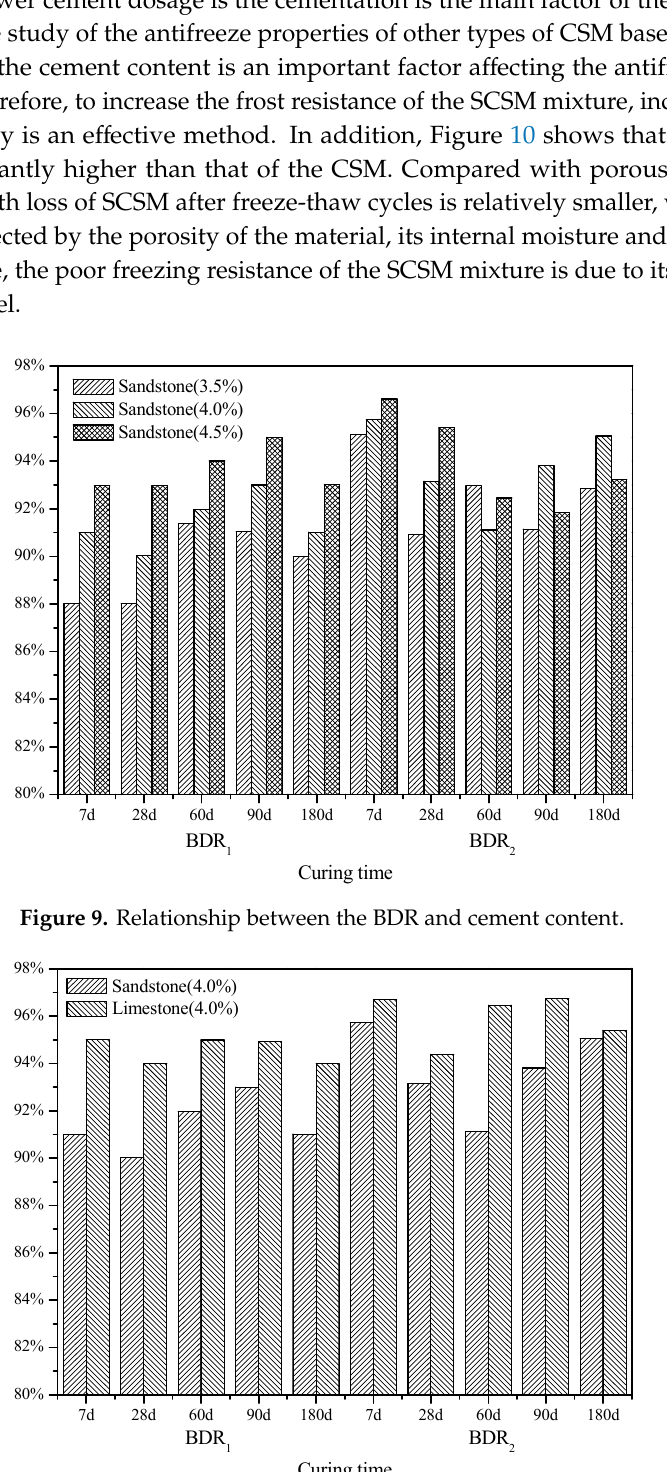
Figure 10. Relationship between the BDR and aggregate